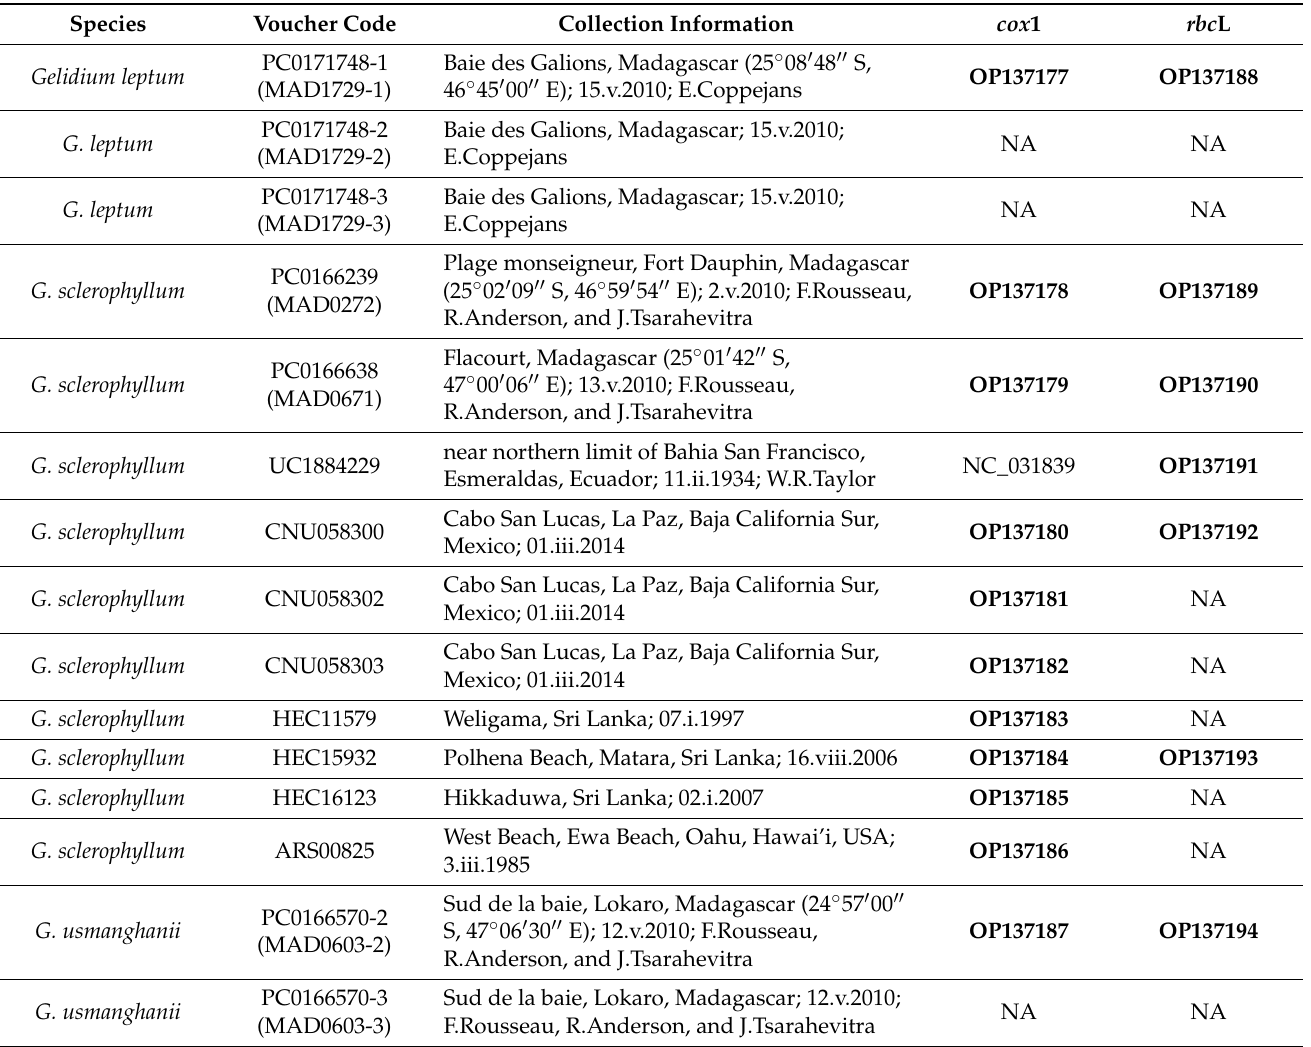
Table 1. Materials used in the present